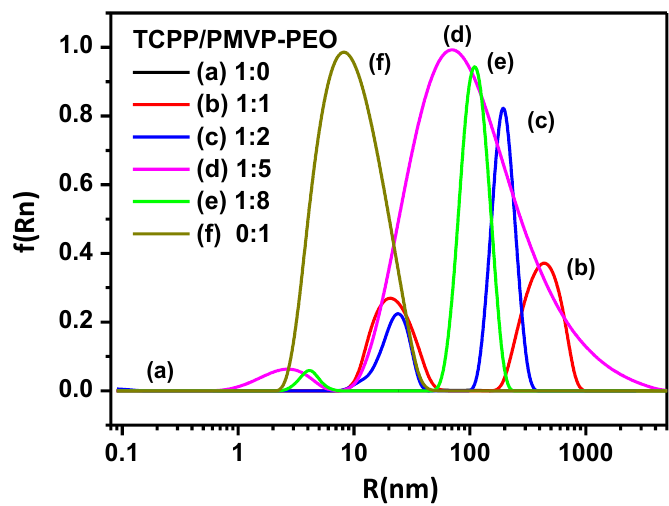
Figure 3. DLS results of polyion complex micelles formed by TCPP and PMVP 41 - b -PEO 205 at the charge ratios of ( a ) 1:0; ( b ) 1:1; ( c ) 1:2; ( d ) 1:5; ( e ) 1:8 and ( f ) 0:1. PMVP-PEO is an abbreviation of PMVP 41 - b -PEO 205 .